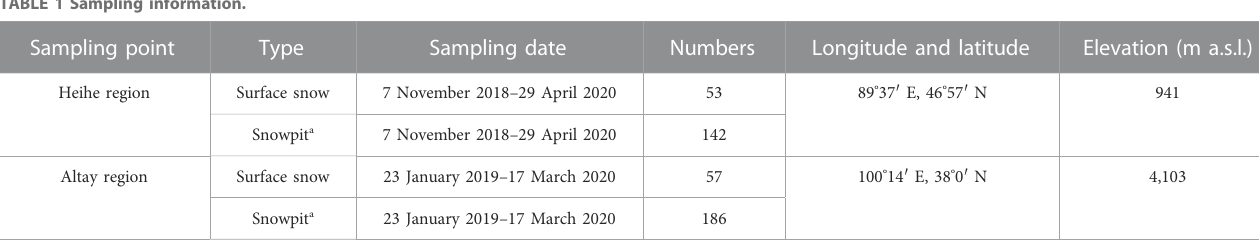
TABLE 1 Sampling